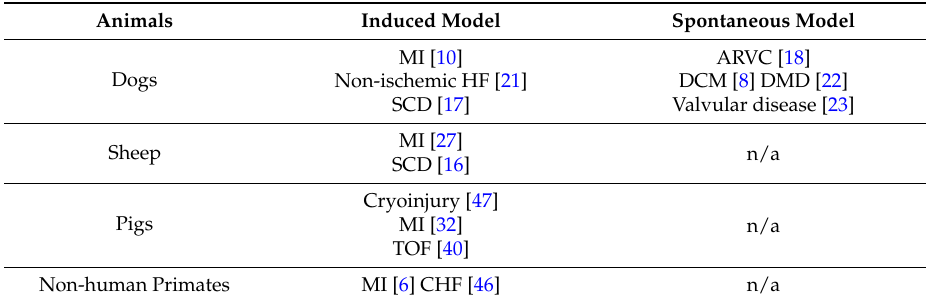
Table 2. Relevant large animal models for cardiac disease (only one reference is listed for each model. See the main text for more